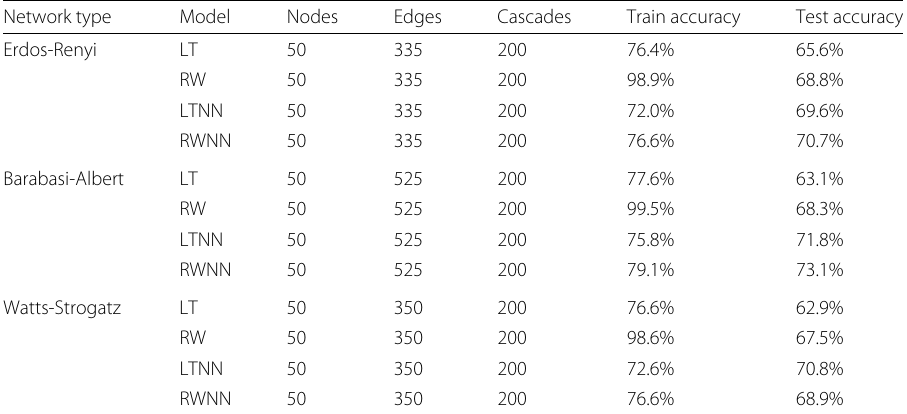
Table 1 Performance of synthetic data Network